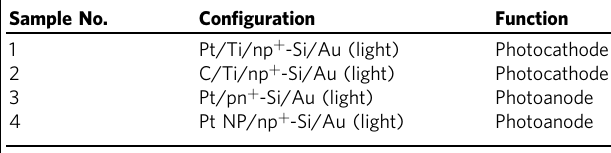
Table 1 Photoelectrode design a and